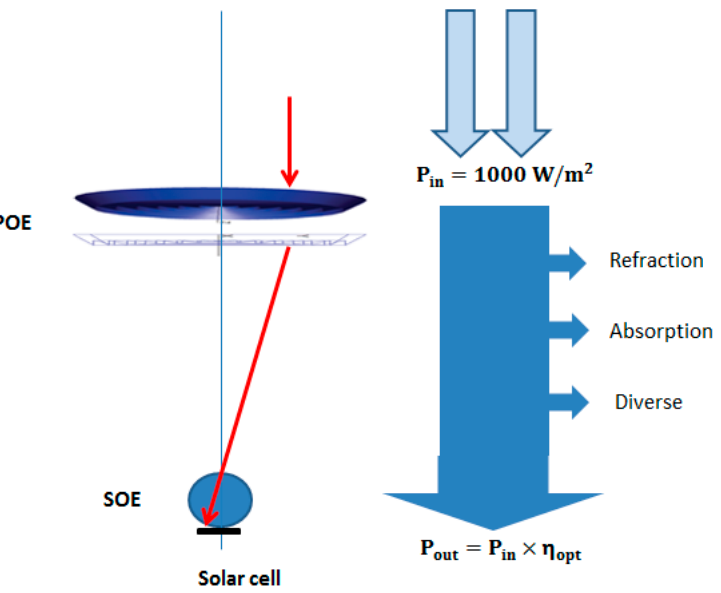
Figure 5. A micro-concentrator’s main optical power losses.